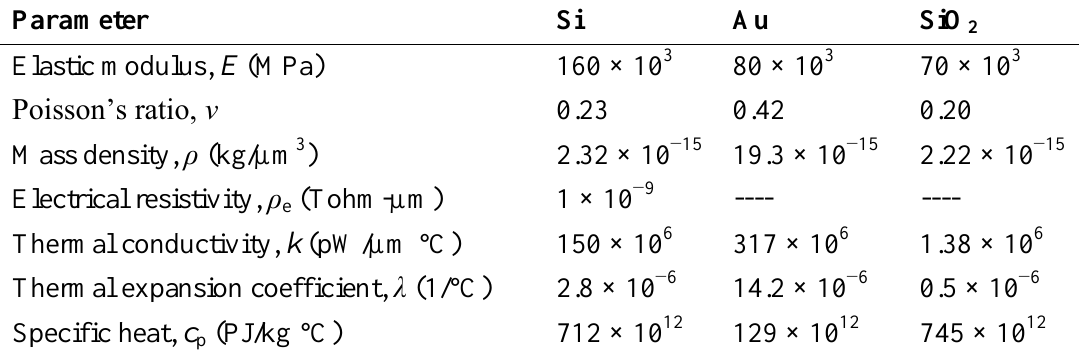
Table 2. Material properties of piezoresistive microcantilevers in µMKS